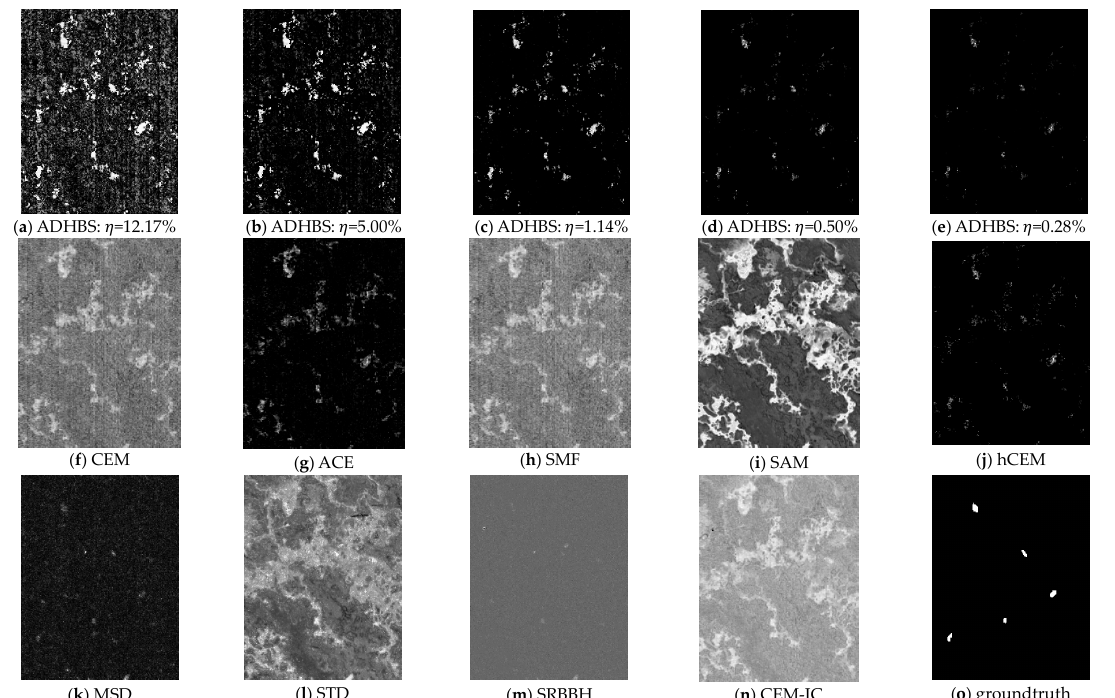
Figure 15. Detection results of the Okavango Delta data. ( a - e ) the results of the proposed ADHBS method in different layers, corresponding to different degrees of background separation. ( f - n ) the results of CEM, ACE, SMF, SAM, hCEM, MSD, STD, SRBBH, and CEM-IC, respectively. ( o ) the ground truth of the target.